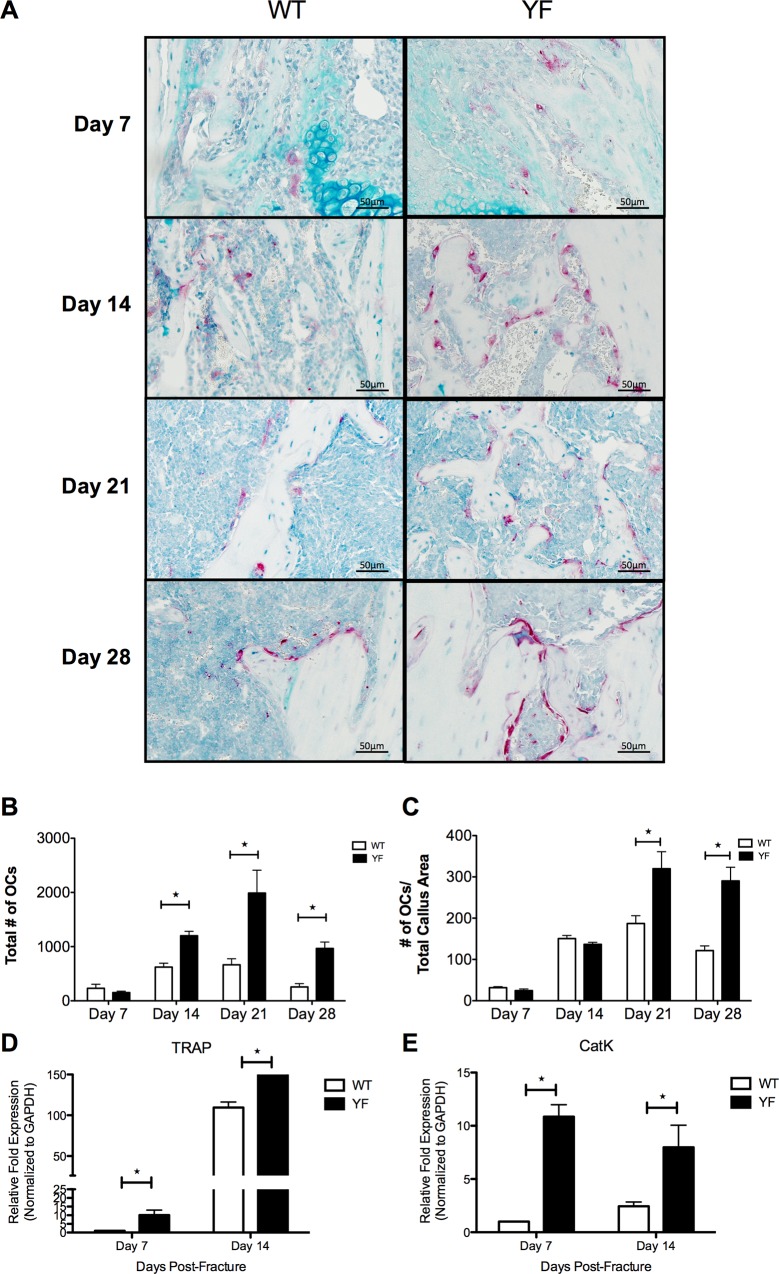
Lack of Cbl-PI3K interaction results in increased osteoclast number, and up-regulation of osteoclastic markers TRAP and Cathepsin K in remodeling fracture calluses.Mid-sagittal sections of fractured femora were TRAP stained and counterstained with Alcian Blue and Hematoxylin. A. Representative sections at 7, 14, 21, and 28 days post-fracture. Bar charts show B. Total number of osteoclasts and C. Ratio of osteoclast number over total callus area. n = 5–6, *p<0.05 vs. WT. Cells from sections of calluses at 7 and 14 days post-fracture were harvested by LCM, and expression of D. TRAP and E. Cathepsin K were quantified by RT-PCR. n = 3, *p<0.05 vs. WT.